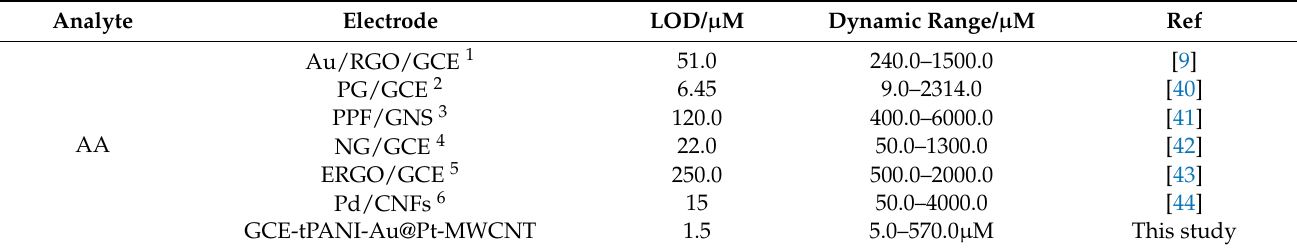
Table 2. Comparison of GCE-tPANI-Au@Pt-MWCNT with the existing electrochemical sensors reported for the detection of ascorbic acid (AA), levodopa (LD), acetaminophen (AC), diclofenac (DI), acetylsalicylic acid (AS) and caffeine (CA) in the